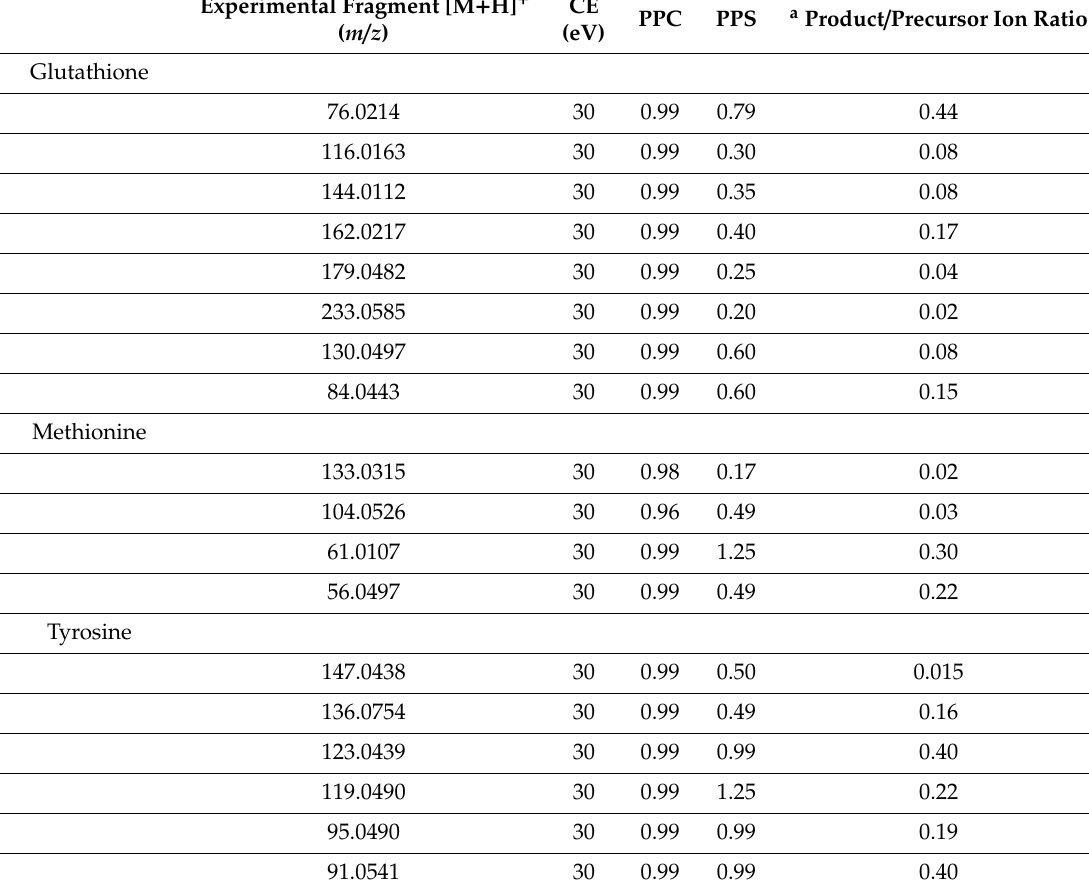
Table 2. Statistical evaluation of glutathione, methionine, and tyrosine peak groups performed by ScoresDIA.R function. Extracted from data acquired on an LC-Q-Exactive Hybrid Quadrupole-Orbitrap device. Recommended values for PPC are ≥ 0.7. Good chromatographic similarity is indicated by 0.3 ≥ PPS ≥ 3. Abbreviations used: CE, Collision Energy; PPC, peak-to-peak Pearson correlation; PPS, peak-to-peak shape